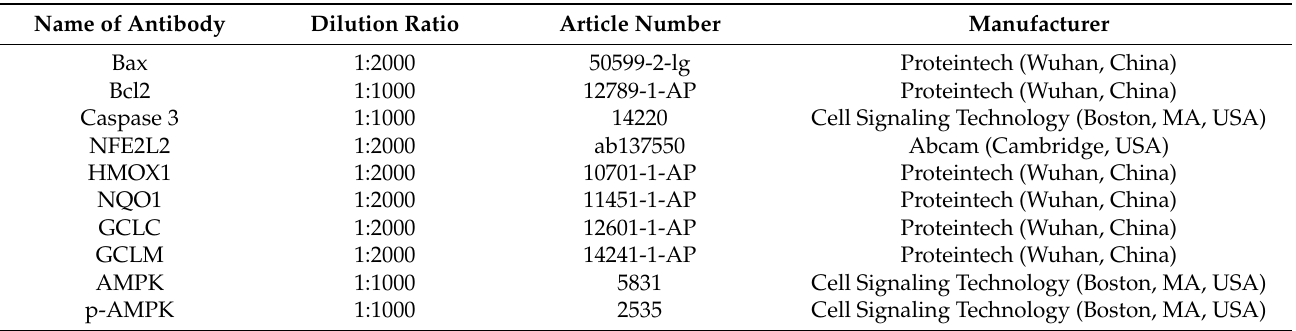
Table 2. Antibody information for Western